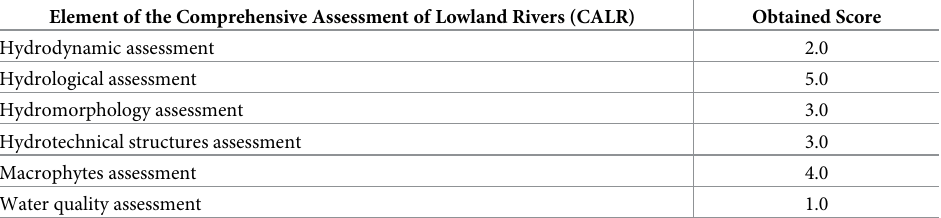
Table 5. Results of individual parts of the Comprehensive Assessment of Lowland Rivers obtained for the Tro- janka River. Element of the Comprehensive Assessment of Lowland Rivers